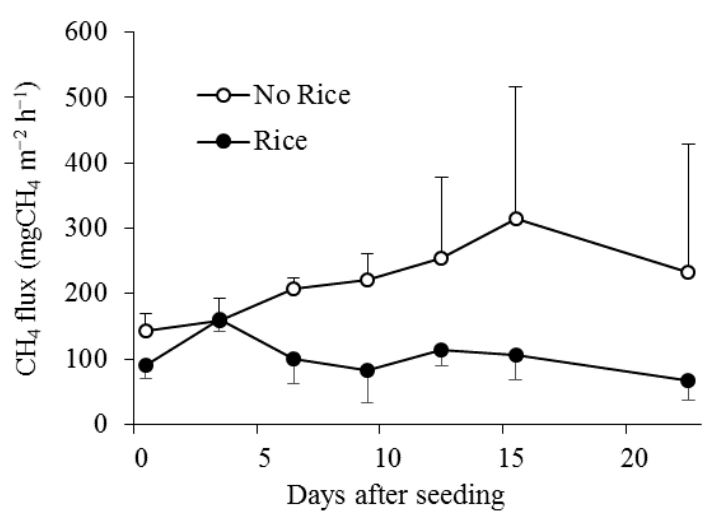
Figure 4. Seasonal CH emission in paddy fields. Average CH emissions of rice-planted areas and no-rice-planted areas in triple 4 4 cropping rice fields in the Mekong Delta. Summer–Autumn season (2016). The paddy fields received incorporated rice straw of the previous crop. Error bars are s.d. (n =